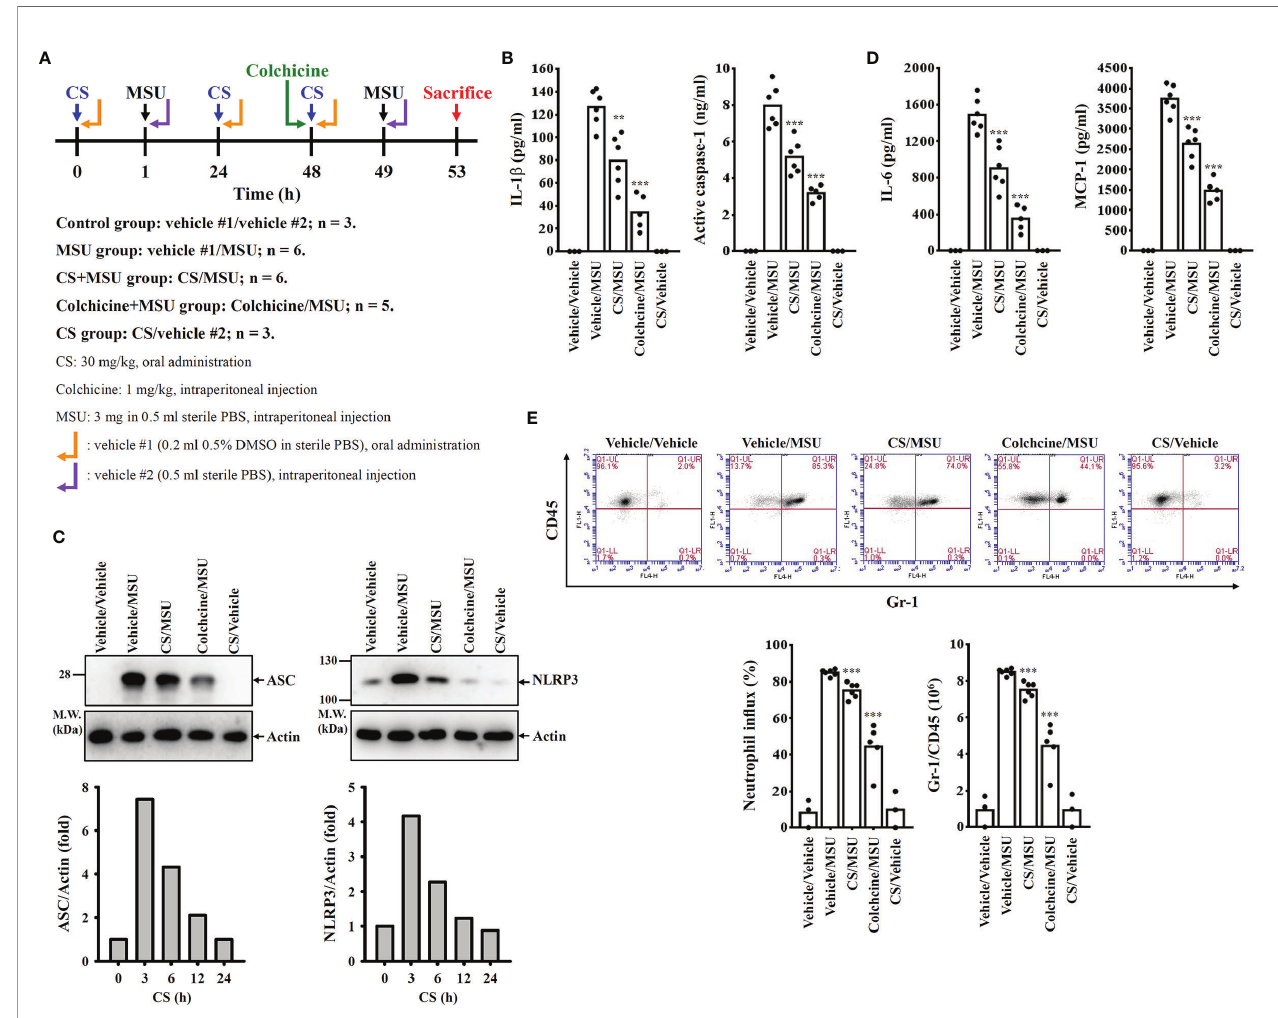
FIGURE 7 | Oral administration of candesartan reduces the NLRP3 in fl ammasome activity in a mouse model of MSU-mediated peritonitis. (A) The scheme of the mice experiments. (B) The levels of IL-1 b and active caspase-1 in the peritoneal lavage fl uids were measured by ELISA. (C) The levels of ASC and NLRP3 in the peritoneal cells were measured by Western blot. (D) The levels of IL-6 and MCP-1 in the peritoneal lavage fl uids were measured by ELISA. (E) Neutrophil in fl ux was quanti fi ed by Gr-1 and CD45 staining. The Western blot images are representative results, and the histogram shows the band intensity. ** and *** indicate a signi fi cant difference at the level of p <0.01 and p <0.001, respectively, compared to the Vehicle/MSU